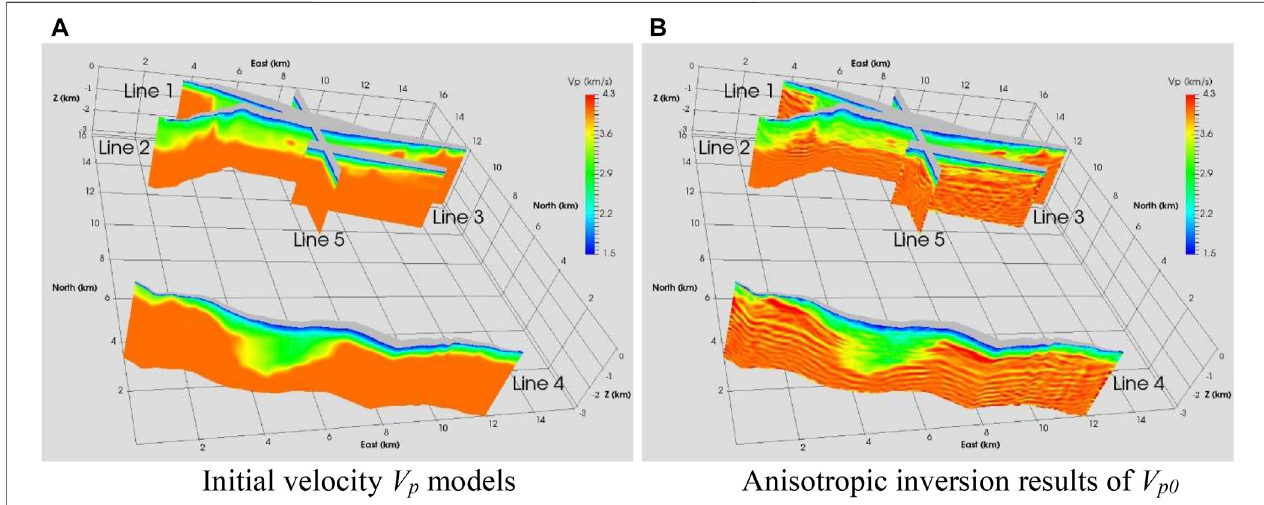
FIGURE 9 | Initial velocity models V p and anisotropic waveform inversion results of V p0 along fi ve 2D lines at Pirouette Mountain and Eleven-Mile Canyon. (A) Initial velocity V p models. (B) Anisotropic waveform inversion results of V p0